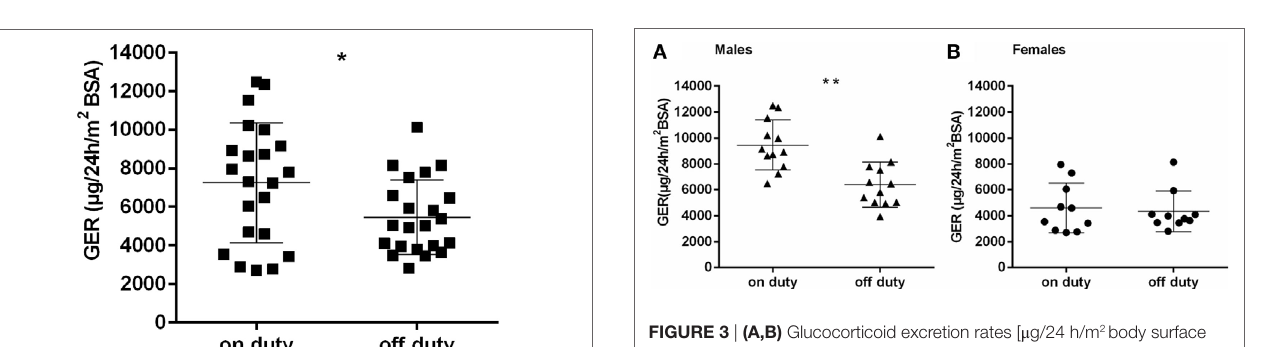
FigUre 3 | (a,b) Glucocorticoid excretion rates [ μ g/24 h/m 2 body surface area (BSA)] in males (a) and females (b) , on and off duty; horizontal bars indicate mean and SD; ** p < 0.001.